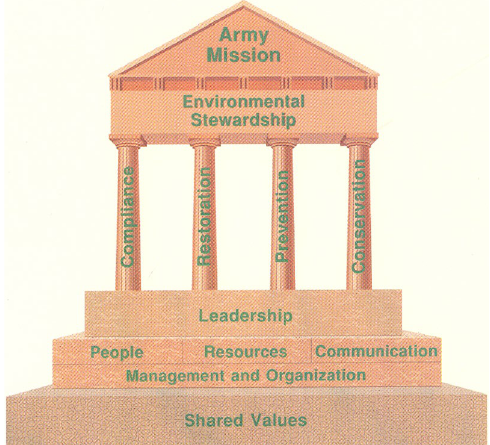
Fig. 4: The US Army Environmental Strategy (Source: US Army-Environmental Center, 2004)